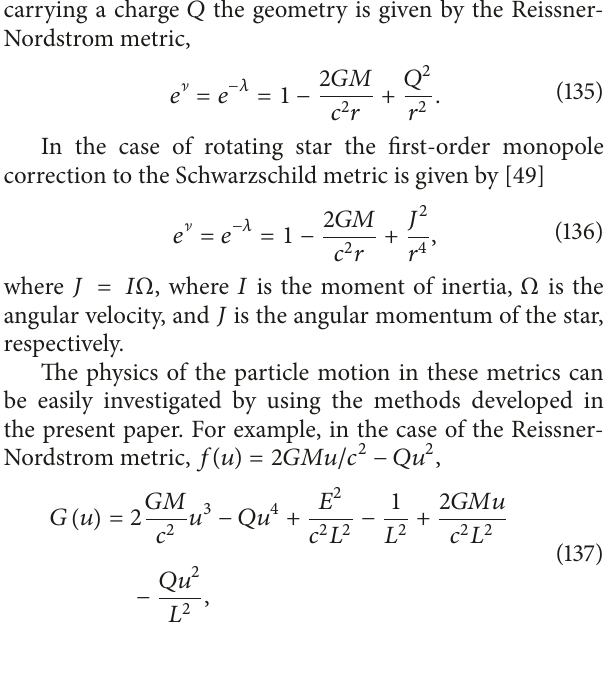
order of approximation, with 𝑢 ≈ 𝑢 0 + 𝑢 1 + 𝑢 2 , we obtain by using the same